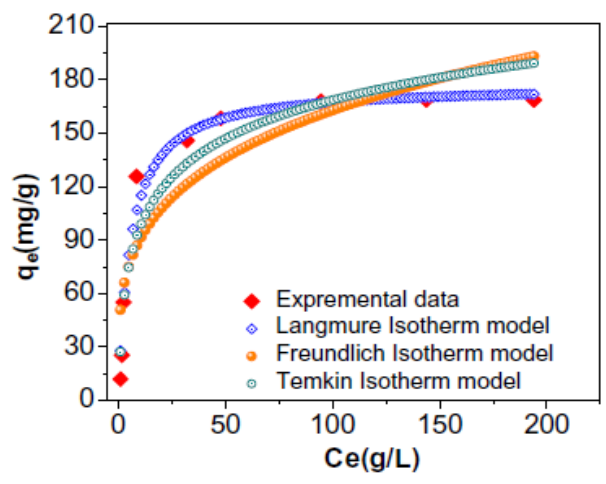
Figure 9. Adsorption isotherm of TC on CDF@MF [19]. Figure 8. Adsorption isotherm of TC on CDF@MF